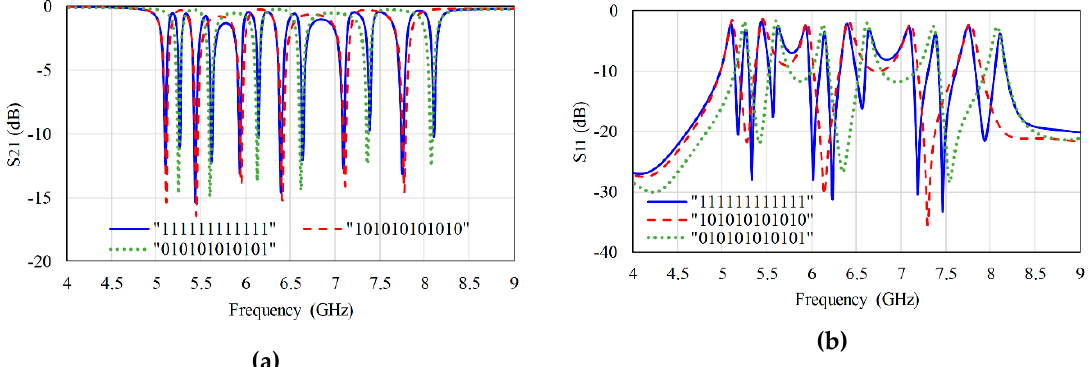
ff erent codes: 111111111111, 101010101010,